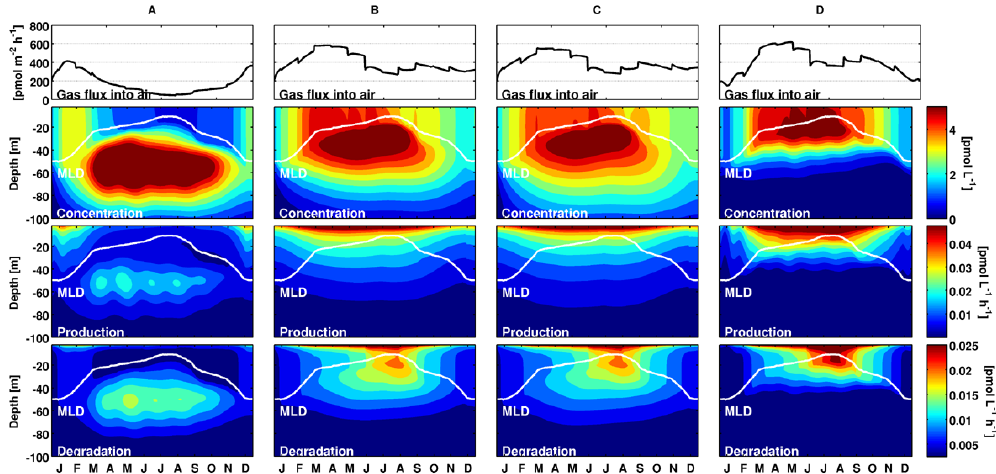
Fig. 1. Methyl iodide concentrations [pmolL − 1 ], production [pmolL − 1 h − 1 ], degradation [pmolL − 1 h − 1 ], and gas exchange [pmolm − 2 h − 1 ] for the experiments Opt1 (column A), Opt2 (column B), Opt3 (column C), and Opt4 (column